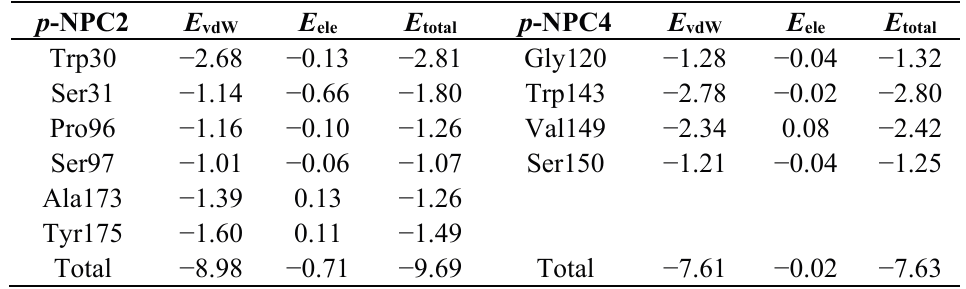
Table 8. The total energy ( E total ), van der Waal energy ( E vdW ), and electrostatic energy ( E ele ) between substrates and individual residues ( E total < − 1.0 kcal·mol − 1 listed in energy rank